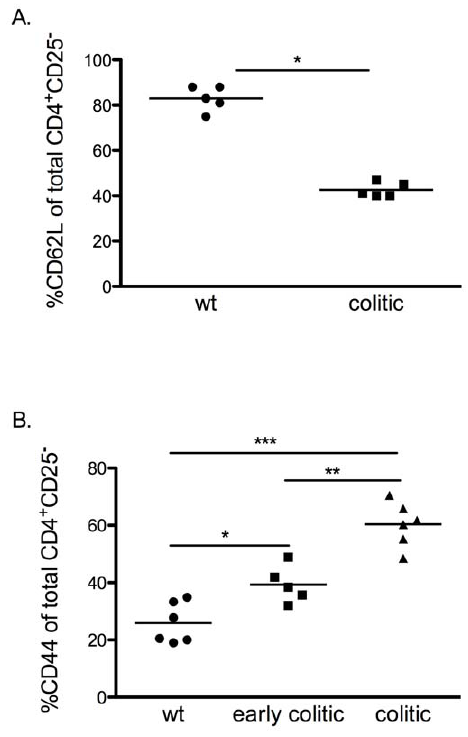
were restricted to the CD4 + T cell population in the MLN in both precolitic and colitic mice, with 80 to 90% residing in the CD4 + CD25 + T cell population. The CD8 + T cell population had almost no expression of CD25 ( , 1% positive cells, data not shown) and Foxp3 expression was detected on less than 2% of CD8 + T cells [Table 1].